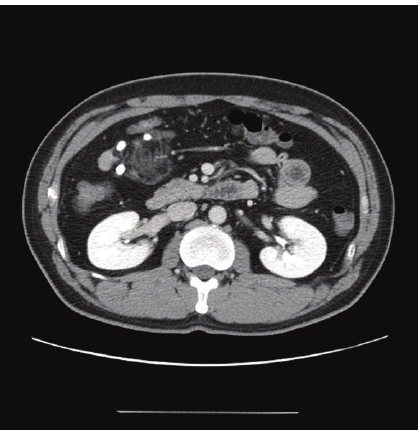
Figure 1: Axial contrast-enhanced CT scan. It shows the tumor measuring 4 cm in size and having fat component in the mesentery.